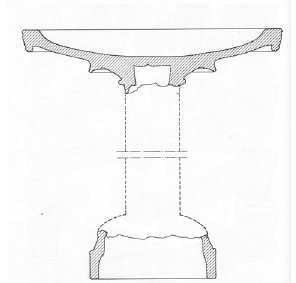
Figure 2. Louterion (from Allegro, 1982).